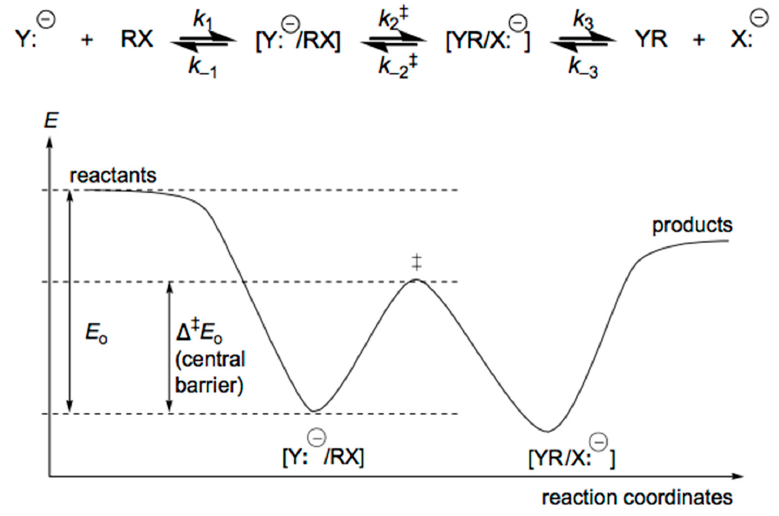
Figure 11. Potential energy hypersurface for gas phase S N 2 substitutions.